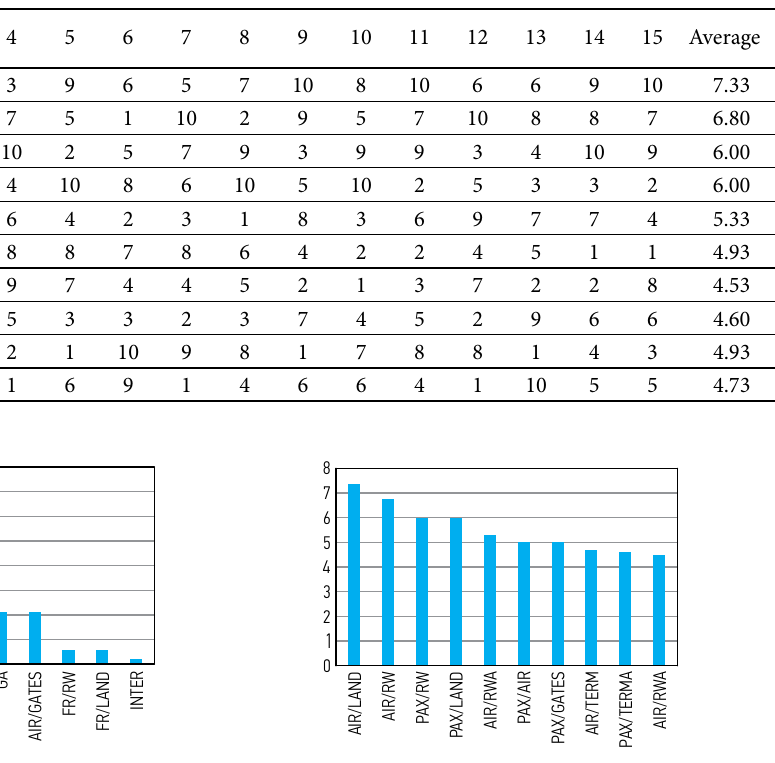
Table 4. The results evaluated by Delphi in the second round